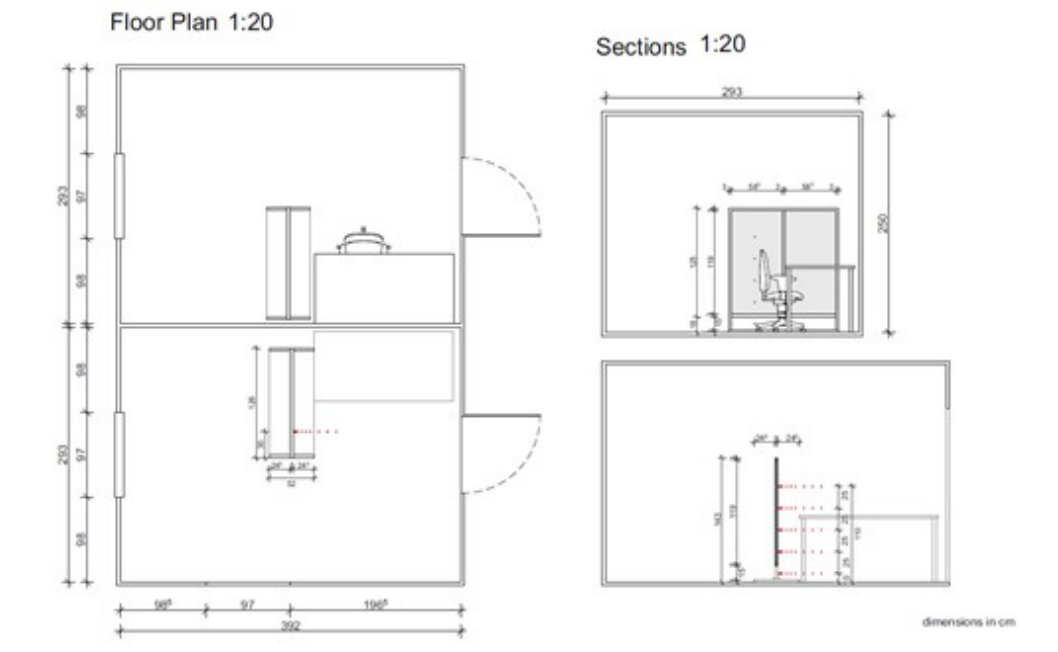
Figure 2. Floor plan and sensors locations at the test